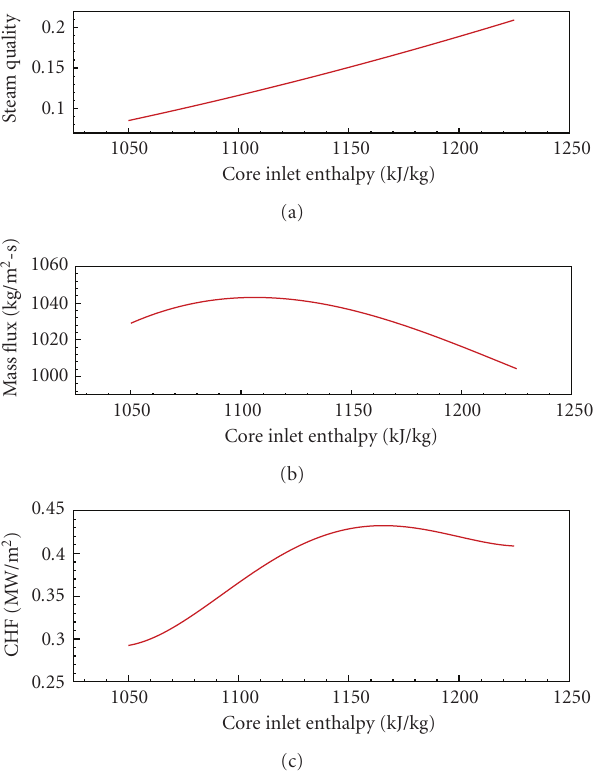
Figure 11: The variations of (a) steam quality, (b) mass flux, and (c) CHF with CIE.